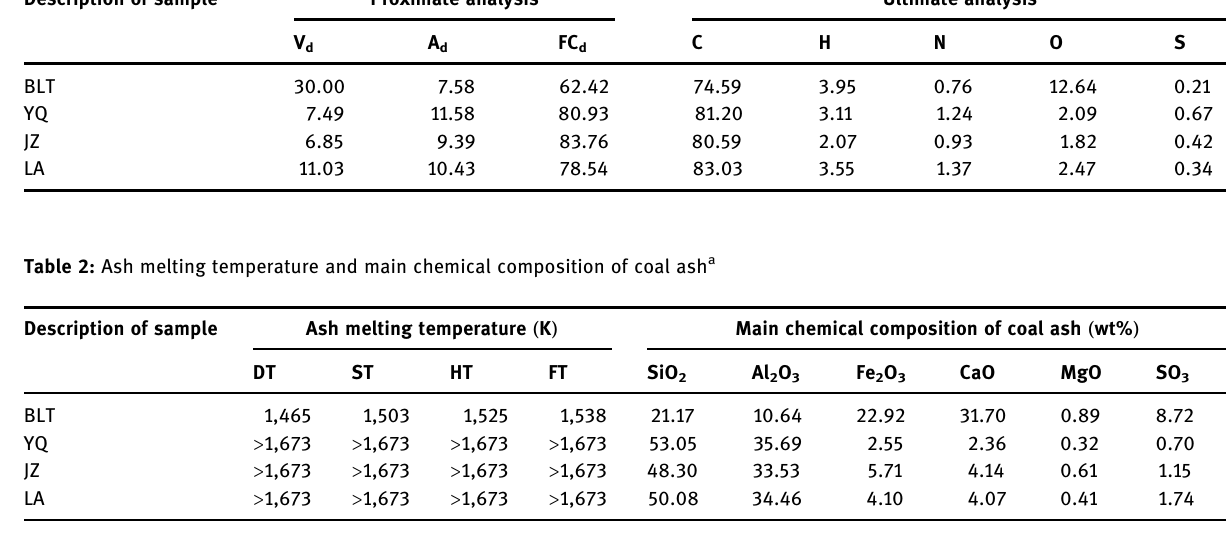
Description of sample